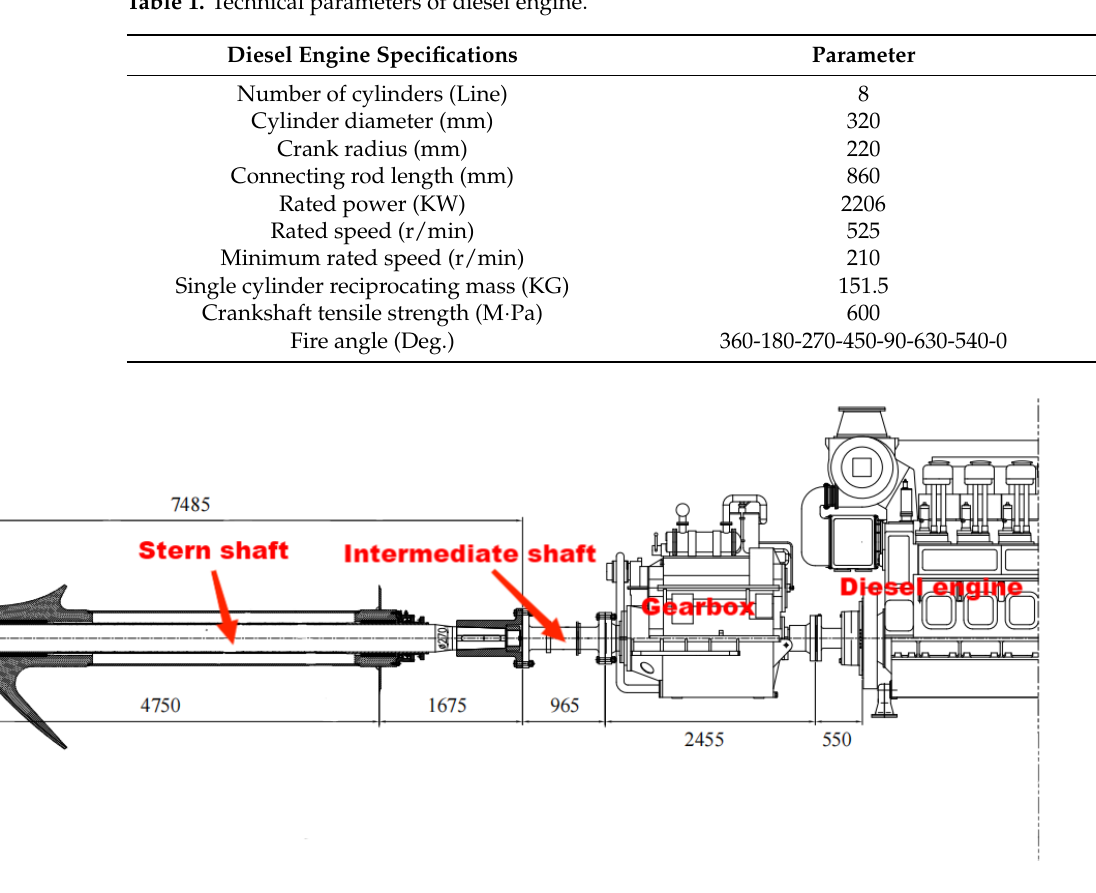
Figure 1. Components of the tested shafting.